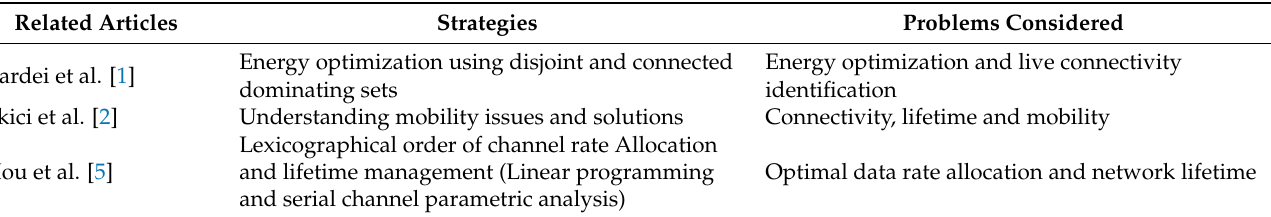
Table 2. WSNs and recognized